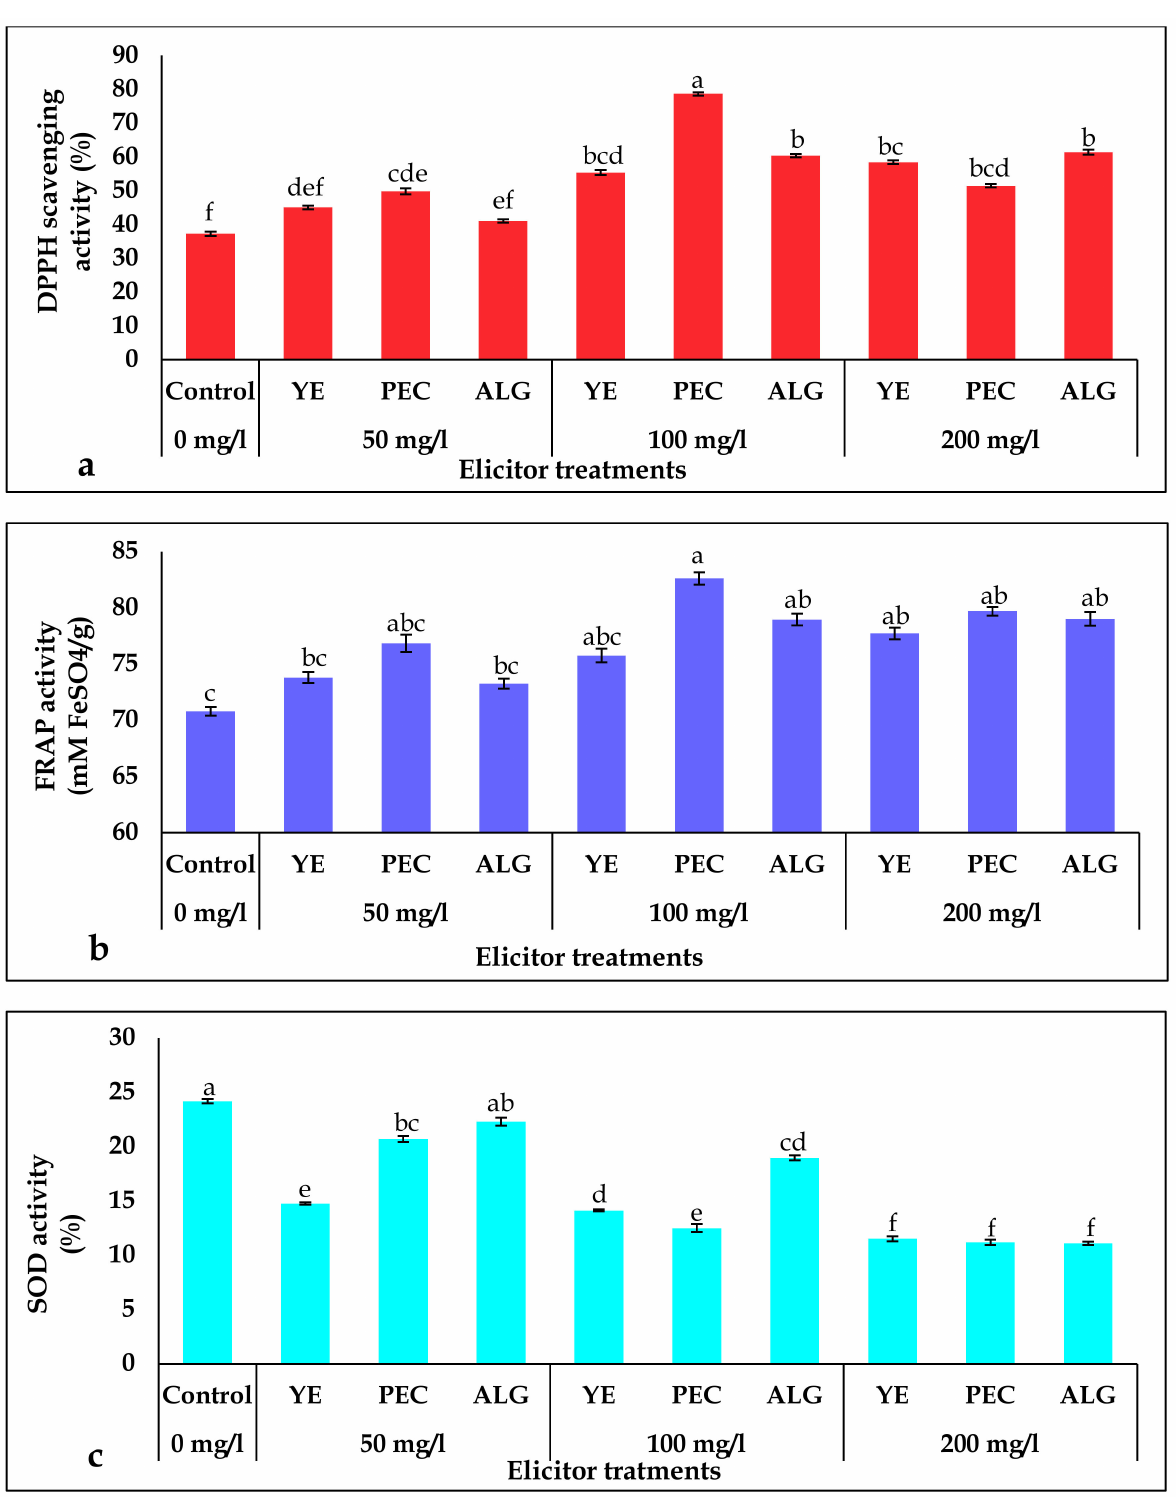
Figure 3. Effect of elicitor treatments on antioxidant activity in P. tuberosa s hoots: ( a ) DPPH activity (%), ( b ) FRAP activity (mM FeSO 4 /g), ( c ) SOD activity (%). Note: Values are mean ± SD, means in a column followed by different letters are significantly different from each other at p < 0.05. Mean values followed by the same letter(s) in a column are not significantly different ( p < 0.05) based on